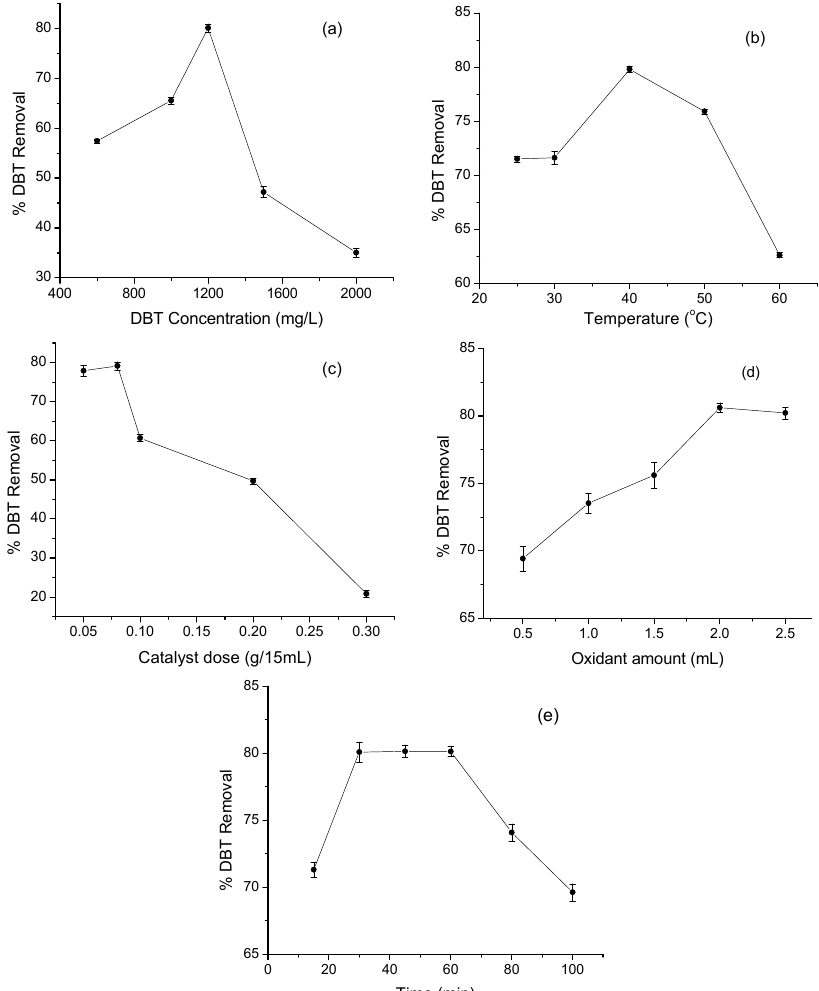
Figure 5. Effect of ( a ) dibenzothiophene (DBT) initial concentration, ( b ) temperature, ( c ) catalyst dose, ( d ) amount of oxidant, and ( e ) time on % DBT removal in the presence of MnO 2 /MrGO catalyst. DBT conversion was investigated as a function of temperature in the range of 25 °C to 60 °C, keeping other parameters constant. The extracted results are displayed in Figure 5b, which exhibit that maximum DBT conversion of up to 80% is achieved at 40 °C, whereas above and below 40 °C, DBT conversion declines. It is proved that higher tem- peratures lead to side reactions and cause rapid dissociation of H 2 O 2 , which leaves DBT unoxidized [40], leading to a lower DBT conversion degree. The majority of literature studies report on the optimum temperature of catalytic ODS in the range of 60 °C to 70